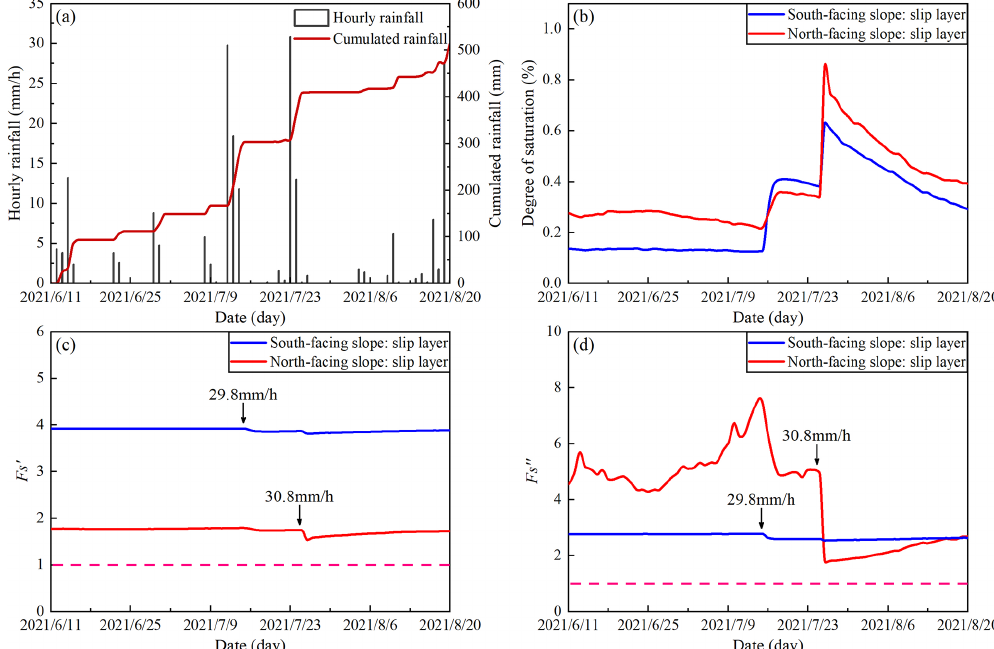
Figure 11. Change in slope stability fluctuation shown by the (a) rainfall records, (b) degree of saturation, (c) stability of finite slope model, and (d) stability of infinite slope model. The dotted pink lines indicate the stability index of